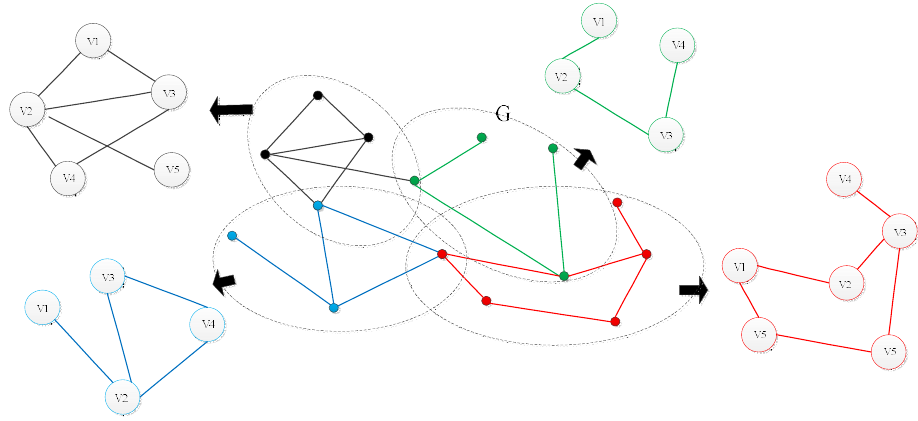
Figure 2. Sub-networks disassembled from a heterogeneous network.